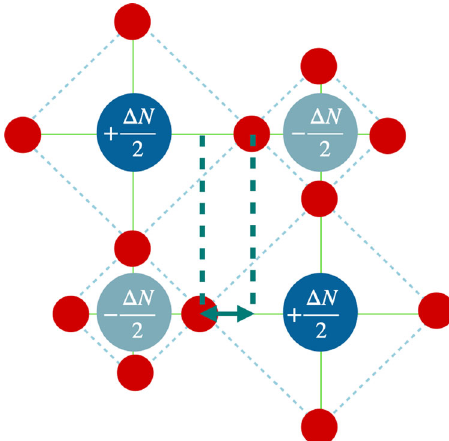
Fig. 2 Schematic of the electronic and structural disproportionation in the insulating state in rare-earth nickelates. NiO 6 octahedra disproportionate electronically and structurally in a three-dimensional checkerboard pattern in R NiO 3 metal – insulator transition compounds, with R a rare-earth. In the low-energy model of refs. 4,6 , the Ni ions corresponding to the larger octahedra have 1e − þ Δ N electrons (dark blue) in their e g shell, while those 2 corresponding to the smaller one (light blue) have 1e − (cid:2) Δ N . The difference 2 in average bond lengths de fi nes Q for the nickelate materials. Red circles correspond to oxygen atoms, while the green arrow is a measure of the oxygen displacement along the Ni-Ni